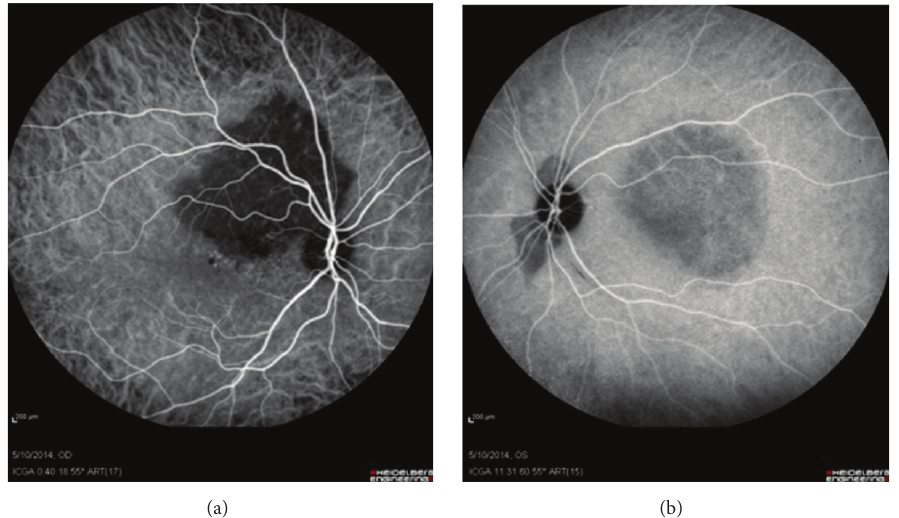
Figure 4: ICG shows well-defined hypofluorescent lesions compatible with tumor in early to mid-phase.